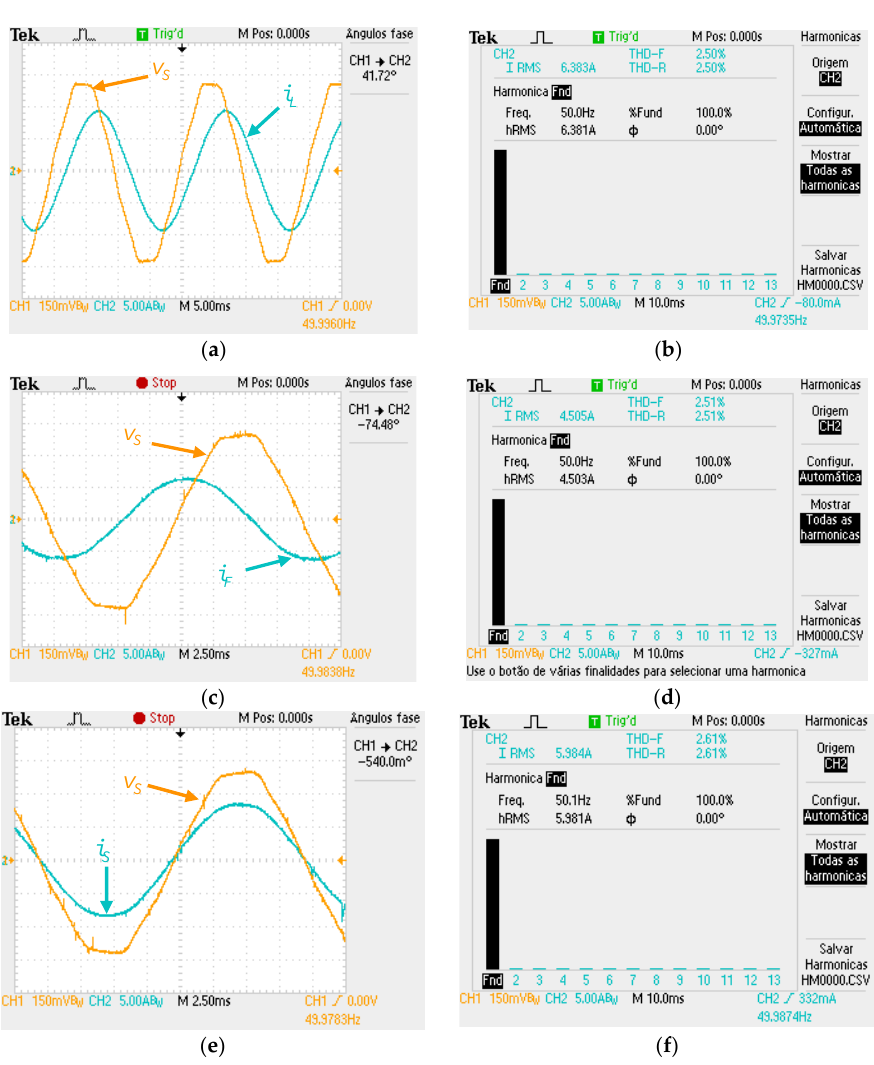
Figure 27. Experimental results of the SAPF with a RL load: ( a ) Source voltage ( v S ) and load current, ( i L ); ( b ) Harmonic spectrum of the load current; ( c ) Source voltage ( v S ) and filter current ( i F ); ( d ) Harmonic spectrum of the current of the filter current; ( e ) Source voltage ( v S ) and source current ( i S ); ( f ) Harmonic spectrum of the source current.